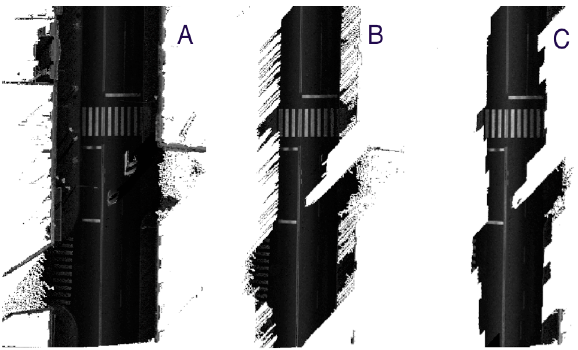
Figure 3. Segmentation of road from the original point cloud: a) original point cloud; b) noise segmentation evaluating each laser cross-section; c) improved segmentation averaging the angles of segmentation with the angles of precedent